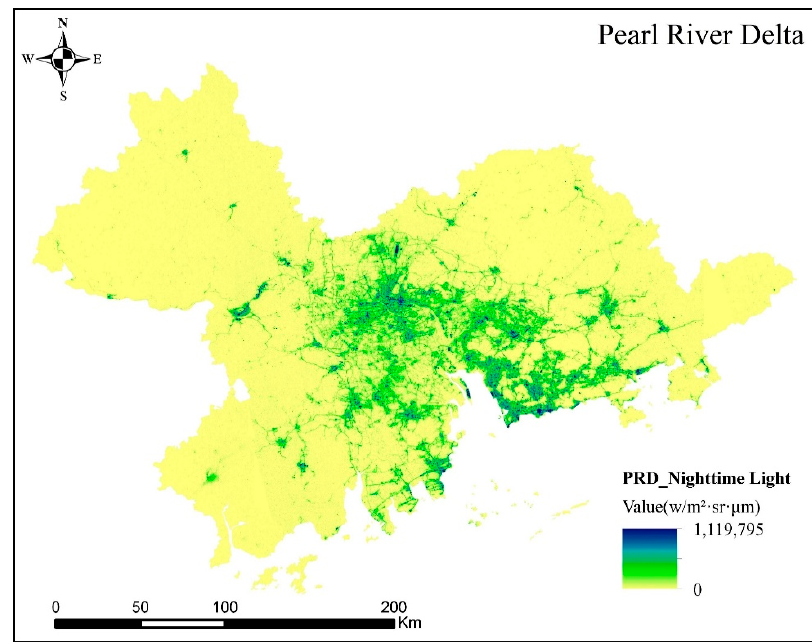
Figure 2. Pre-processing NTL data of urban agglomerations in